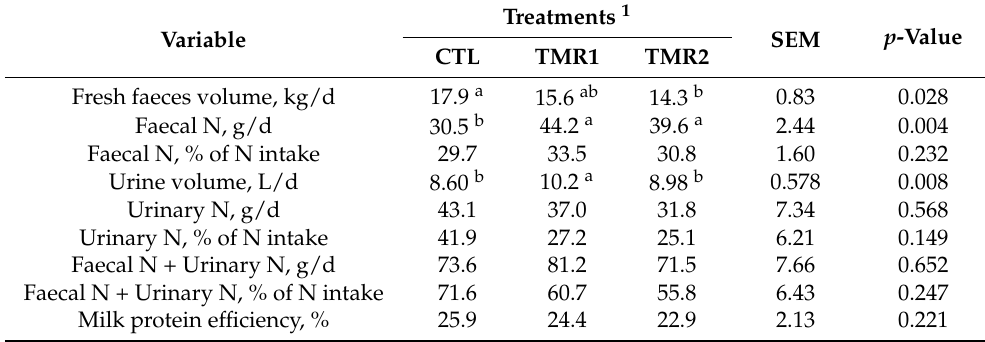
Table 7. Faecal and urinary nitrogen (N)